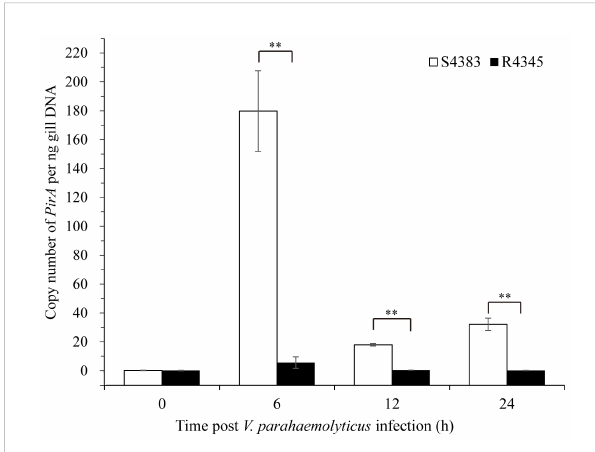
FIGURE 2 The amount of differentially expressed genes (DEGs) between S4383 family and R4345 family during VP AHPND infection. Up represents highly expressed genes in R4345. Down represents highly expressed genes in